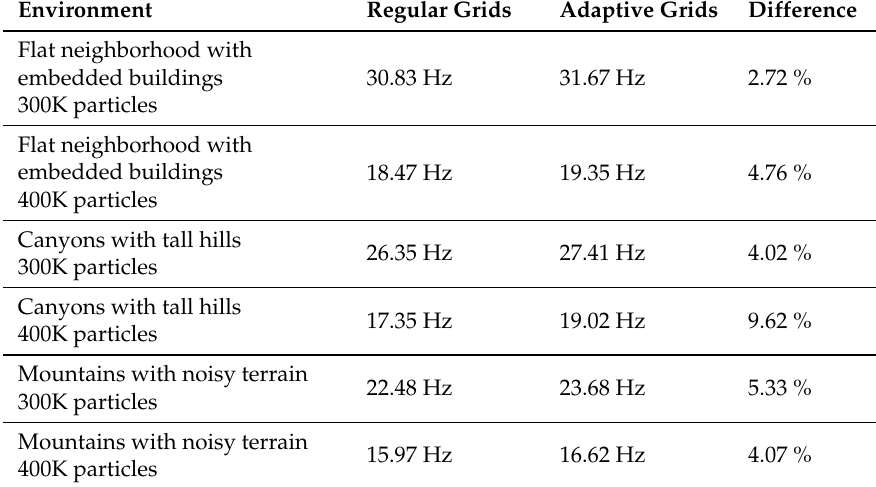
Table 1. Performance comparison of regular grids and adaptive grids under different environmental